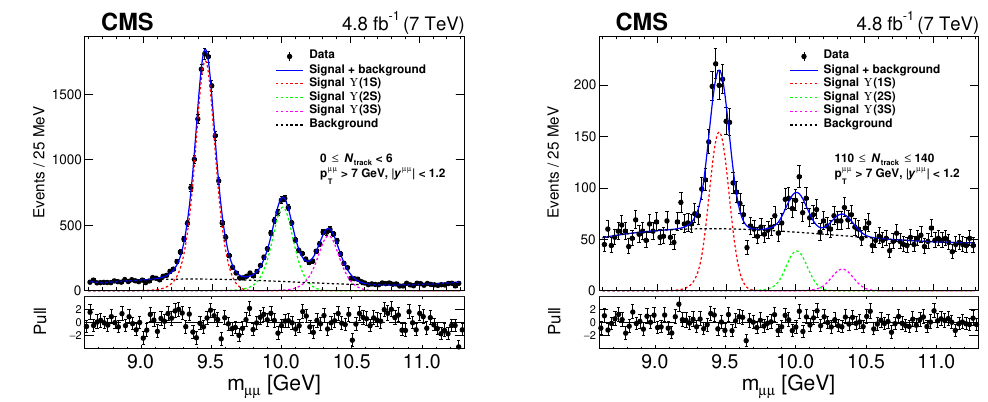
Figure 1 . The (cid:22) + (cid:22) (cid:0) invariant mass distributions for dimuon candidates with p (cid:22)(cid:22)